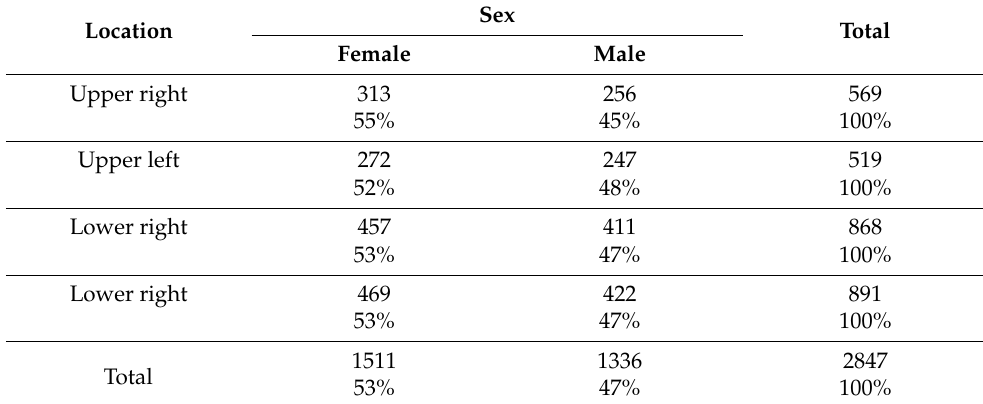
Table 1. The effect of gender on the prevalence of taurodont molars.